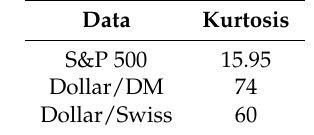
Table 1. Kurtosis of 5 min interval (Cont